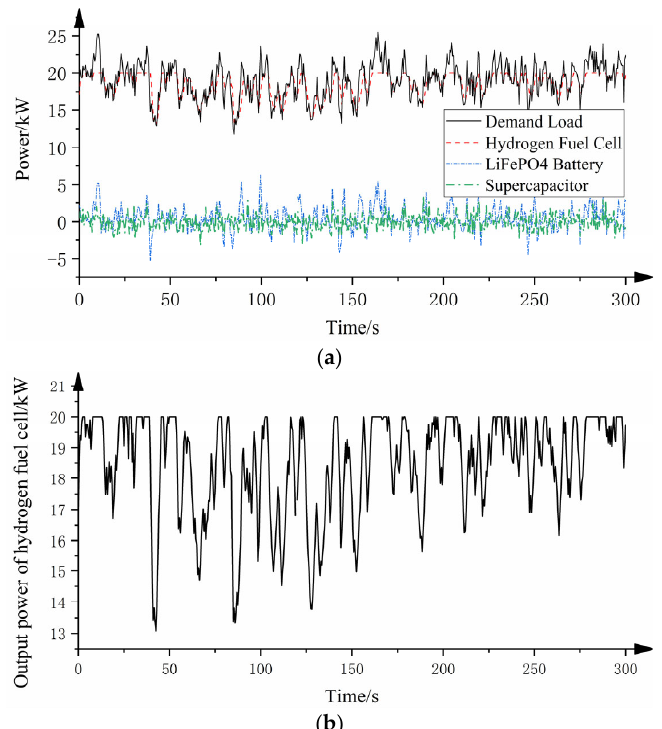
Figure 11. ( a ) The power output of each energy part; ( b ) the power output of the hydrogen fuel cell.